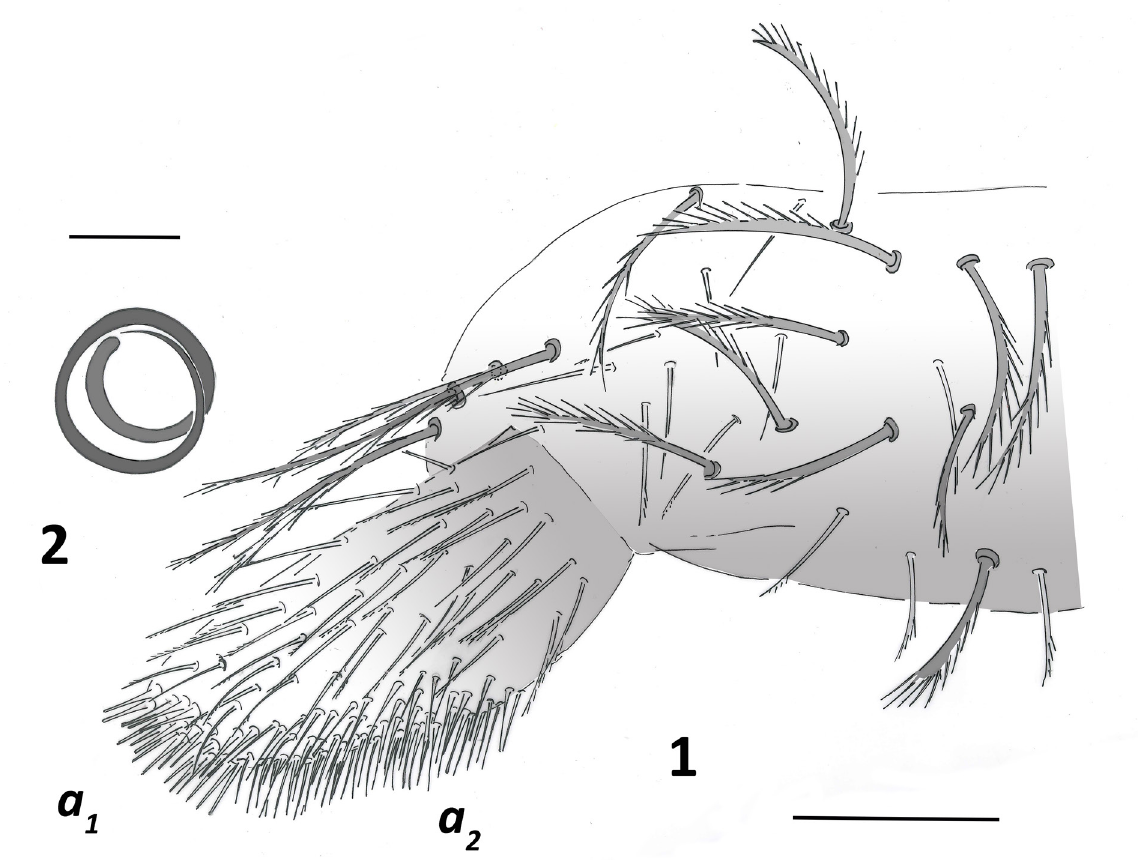
Figs 1–2. Patrizicampa sardoa Condé, 1956, 5 mm long ♂, from Murgulavó Cave, Sardinia (Coll. AS). 1 . First urosternite, right side. 2 . Spiral filament. Scale bars: 20